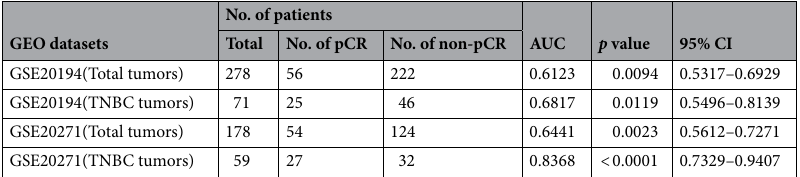
Table 1. ROC analysis of SCD5 in pretreatment tumor biopsy samples for predicting pCR.